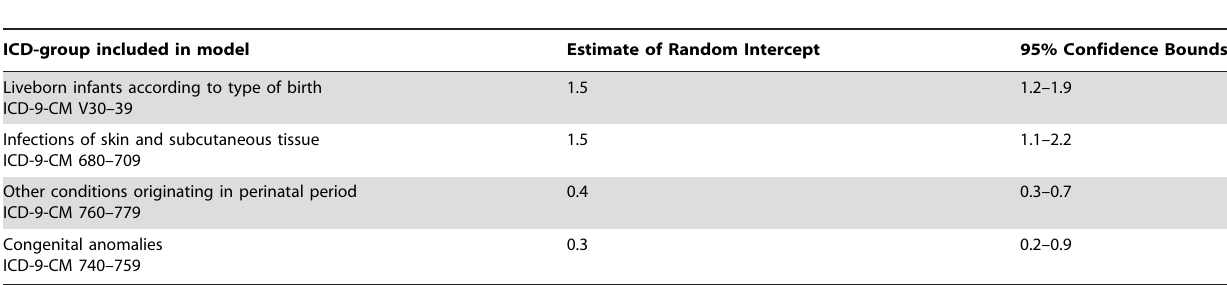
Table 1. The estimates and 95% Confidence Bounds of the variance of the random hospital intercepts on the logit scale in four models for individual diagnostic groups in children under